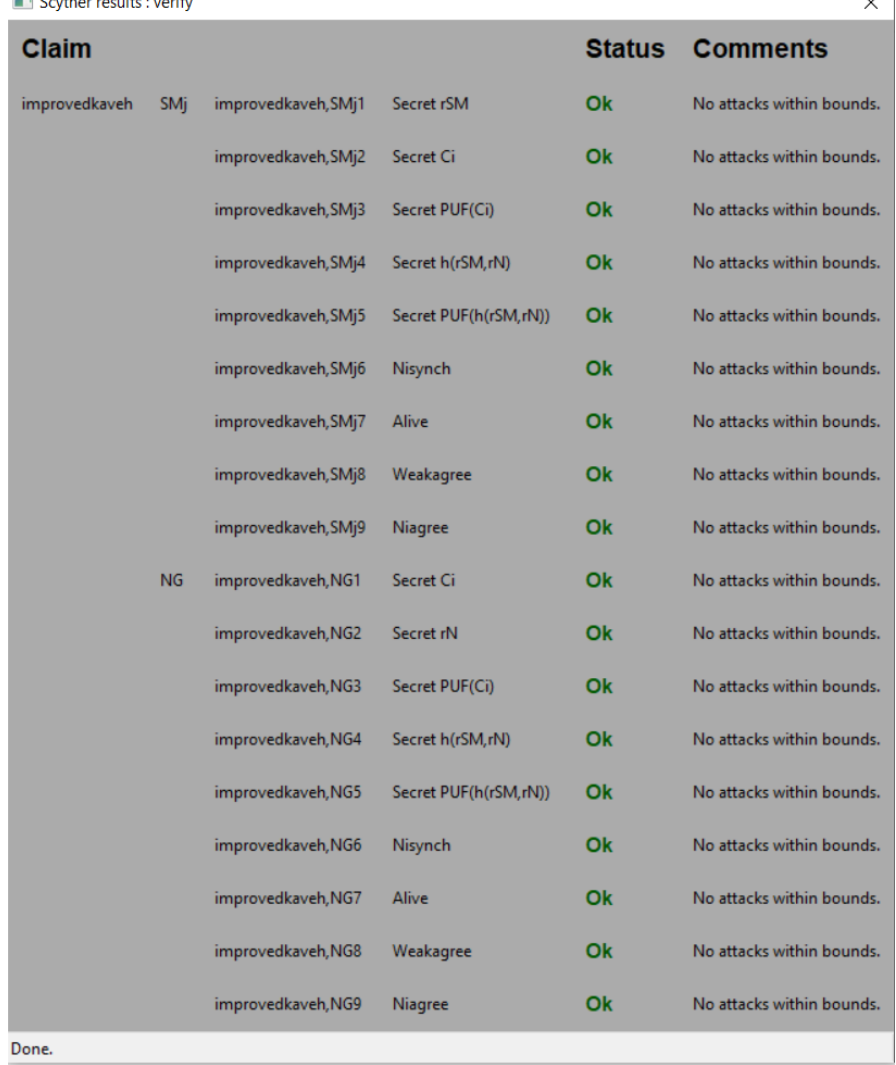
Figure 2. Security evaluation of the proposed protocol using Scyther